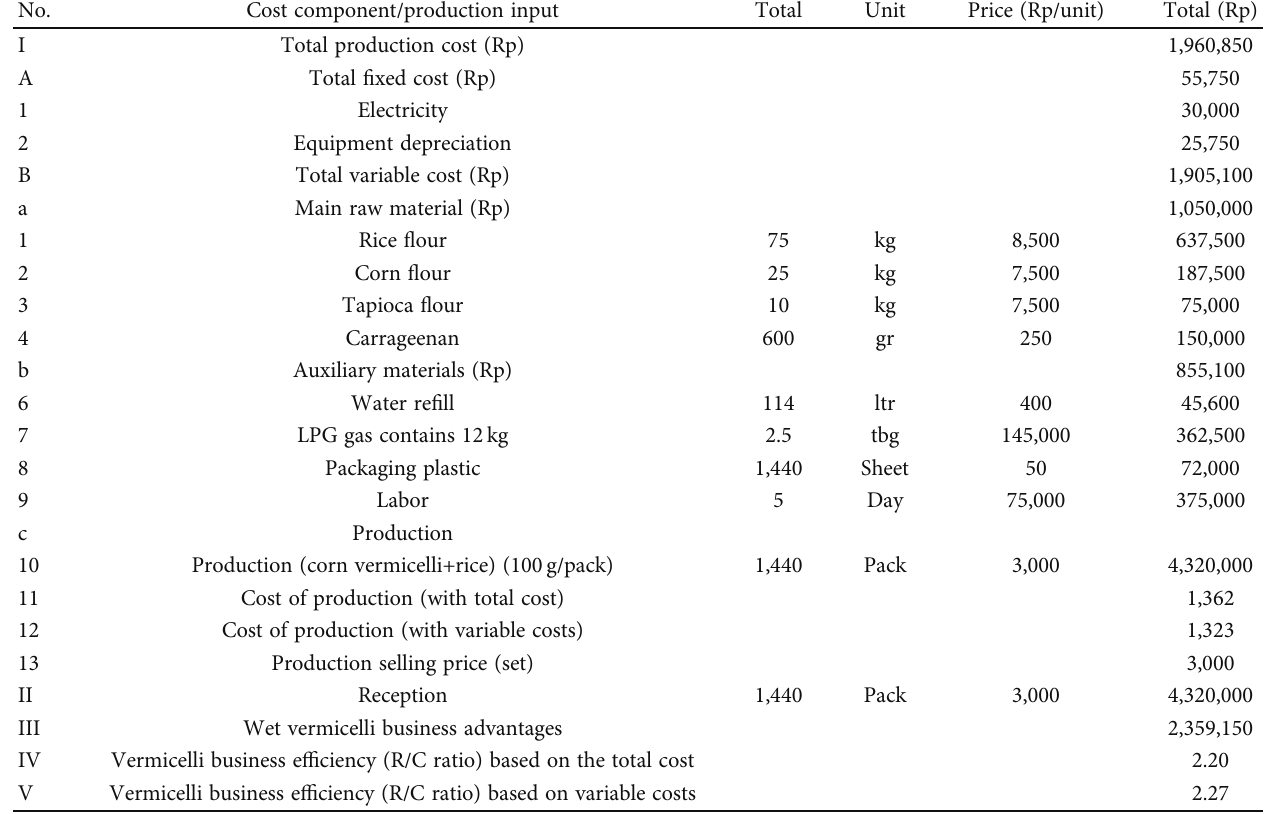
Table 4: Analysis of production costs for making wet vermicelli based on corn and rice fl our mixed.